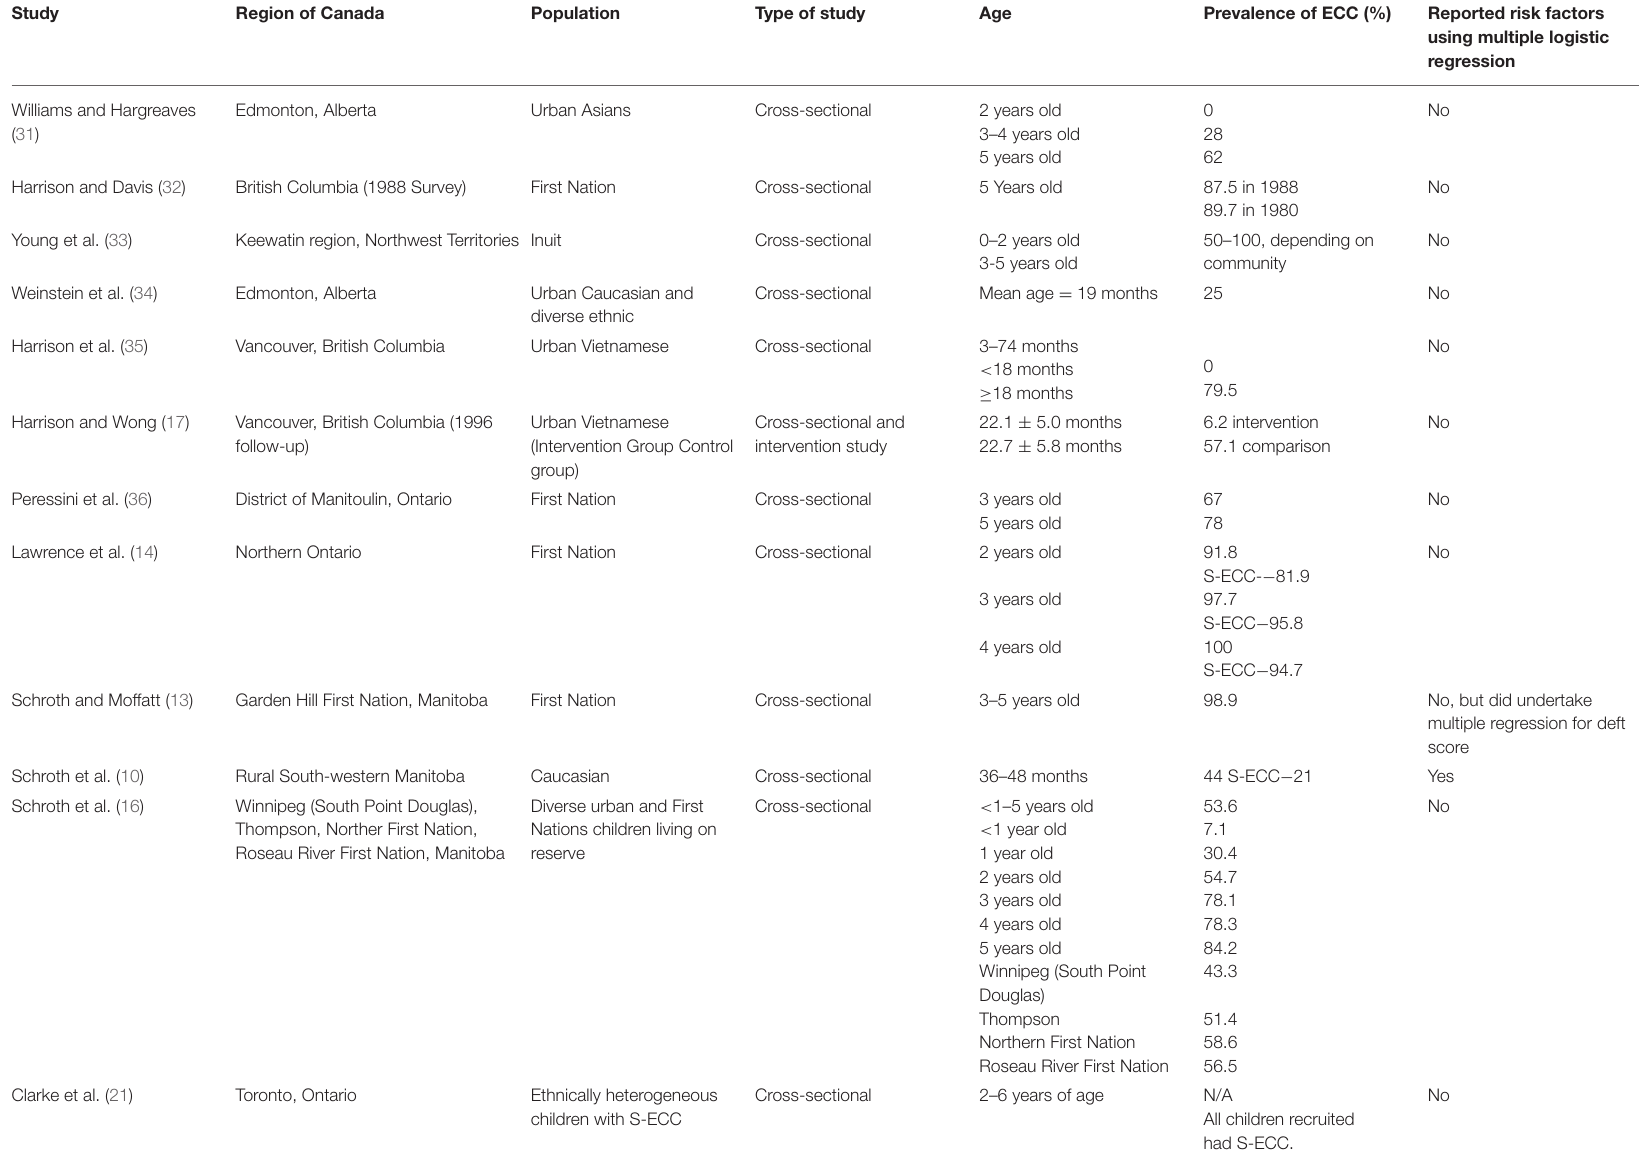
TABLE 1 | Published studies on early childhood caries among pre-school children in Canada over 29